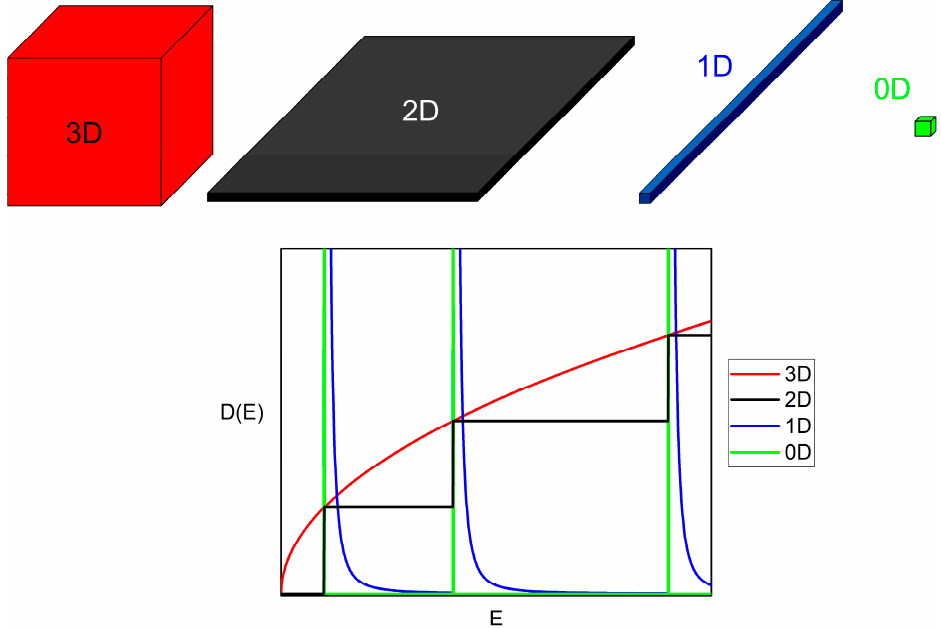
Figure 1. ( Top ) Schemes of bulk materials and the three possible low-dimensional materials derived from them. ( Bottom ) A plot of the functional dependence of the density of states (DOS) of each system.